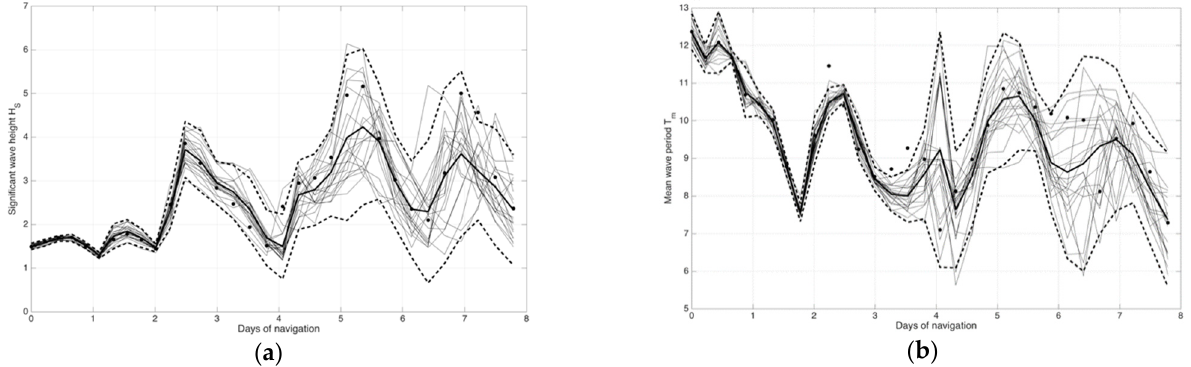
Figure 4. Ensemble forecasts of H S ( a ) and T m ( b ) along the route: ensemble members, thin grey lines; mean of the ensembles, thick black line; 5th and 95th percentiles, dashed lines; actual weather occurred, dots.